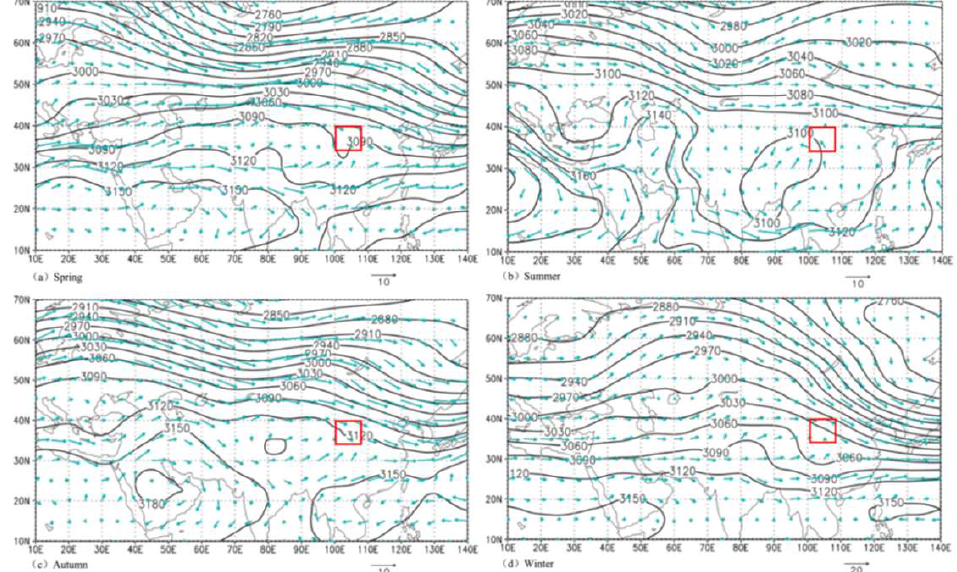
Figure 4. Geopotential height in geopotential meters (gpm) and wind in m/s at 700 hPa in different seasons: ( a ) Spring geopotential height and wind; ( b ) Summer geopotential height and wind; ( c ) Autumn geopotential height and wind; ( d ) Winter geopotential height and wind. Red dashed frames for each subfigure mark the study region.